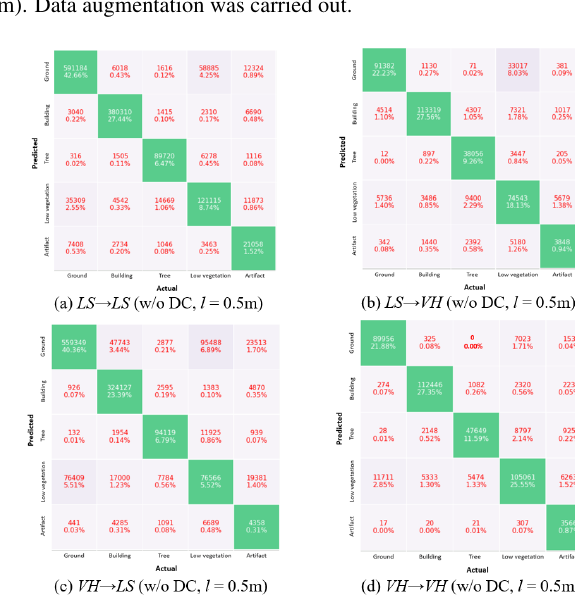
Table 5. Results with intensity ( l = 0 . 5 m). Data augmentation was carried out.